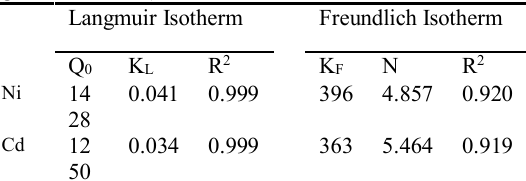
Table 1. Isotherm parameters of cadmium and nickel